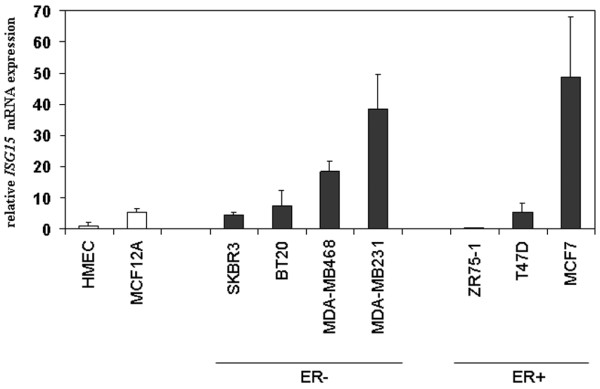
Abundance of the expression of ISG15 mRNA in breast cancer cell lines. Semiquantitative real-time PCR (LightCycler) of ISG15 expression was performed on reverse transcribed RNA from non-malignant (white bars) and malignant cell lines (black bars). ISG15 mRNA expression was low among the non-malignant mammary epithelial cell lines HMEC and MCF12A, whereas ISG15 mRNA transcript levels varied more and in summary were elevated in the investigated cancerous cell lines.